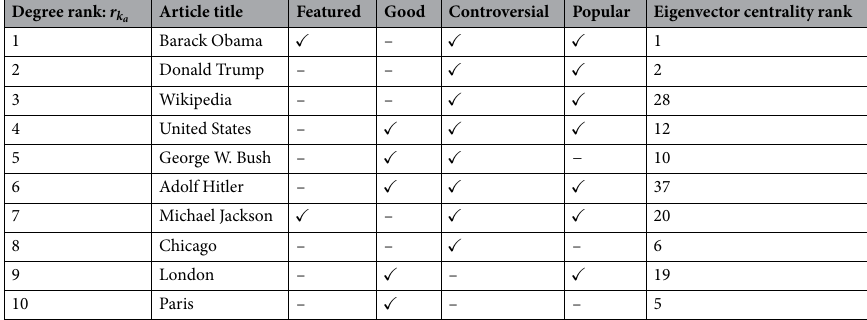
Table 2. Top 10 articles in degree rank. Most of the top articles are “controversial” and “popular”, i.e. listed in the top 100 most popular articles for the period from 2007 to